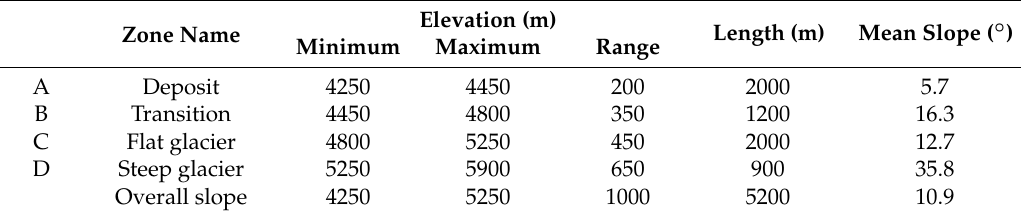
Figure 13. Elevation difference grid (SRTM-HMA DEM) over the 2000 to 2015 period showing volume loss (red) of the glacier but also artefacts to the north and south of it. Glacier outlines and the extent of the avalanche deposit from 2007 are shown in black, the elevation values for the inset are sampled along the dotted line. Elevation contour lines (grey) have 50 m equidistance, sections A, B, C, and D are described in the text. Elevation differences have been limited to a range of ± 150 m. The inset shows elevation profiles extracted from both DEMs along the center line. Table 1. Topographic characteristics of the different zones as derived from the